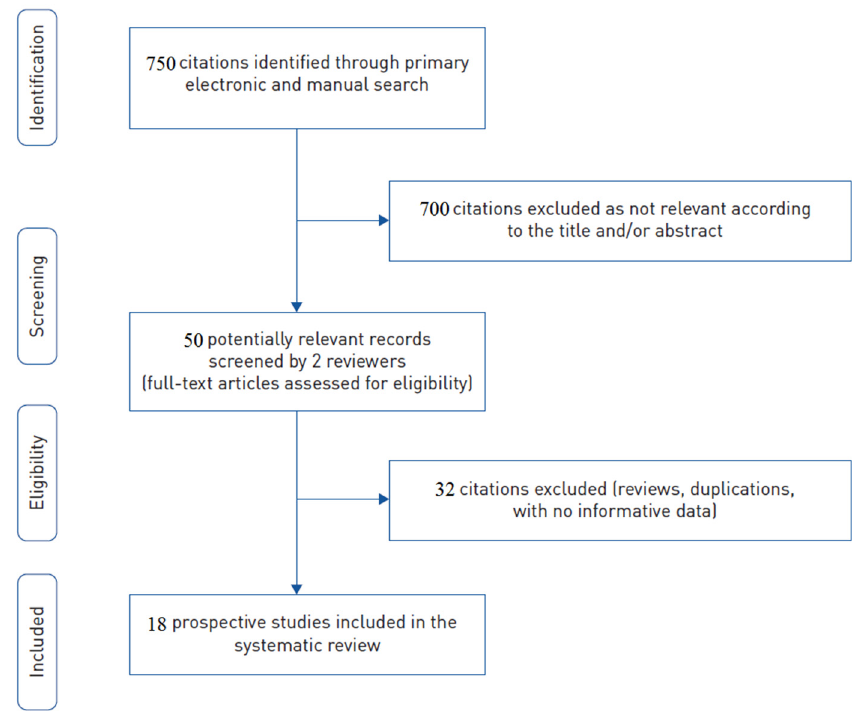
Figure 1. The study selection flow chart. Feasibility